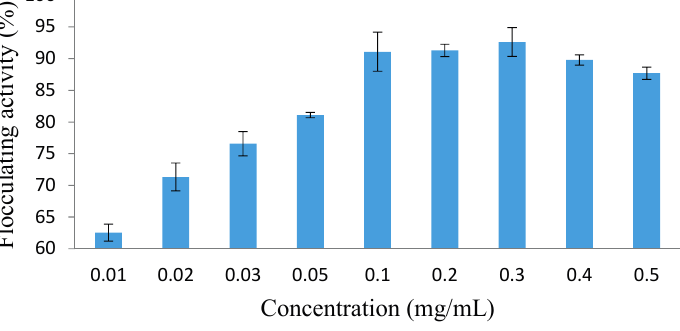
Figure 4. Effect of MBF-UFH concentration on the flocculating activity of purified bioflocculant produced by Bacillus sp.